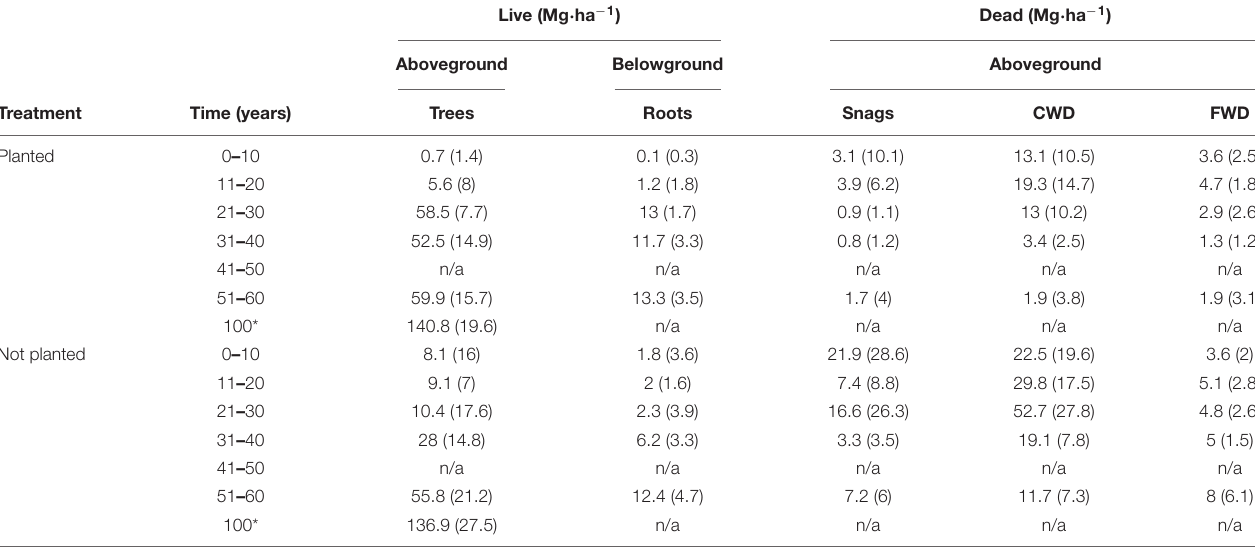
TABLE 2 | Carbon in planted and not-planted stands binned by time since fire and carbon pool [ Mean (SD) ]. Live (Mg · ha − 1